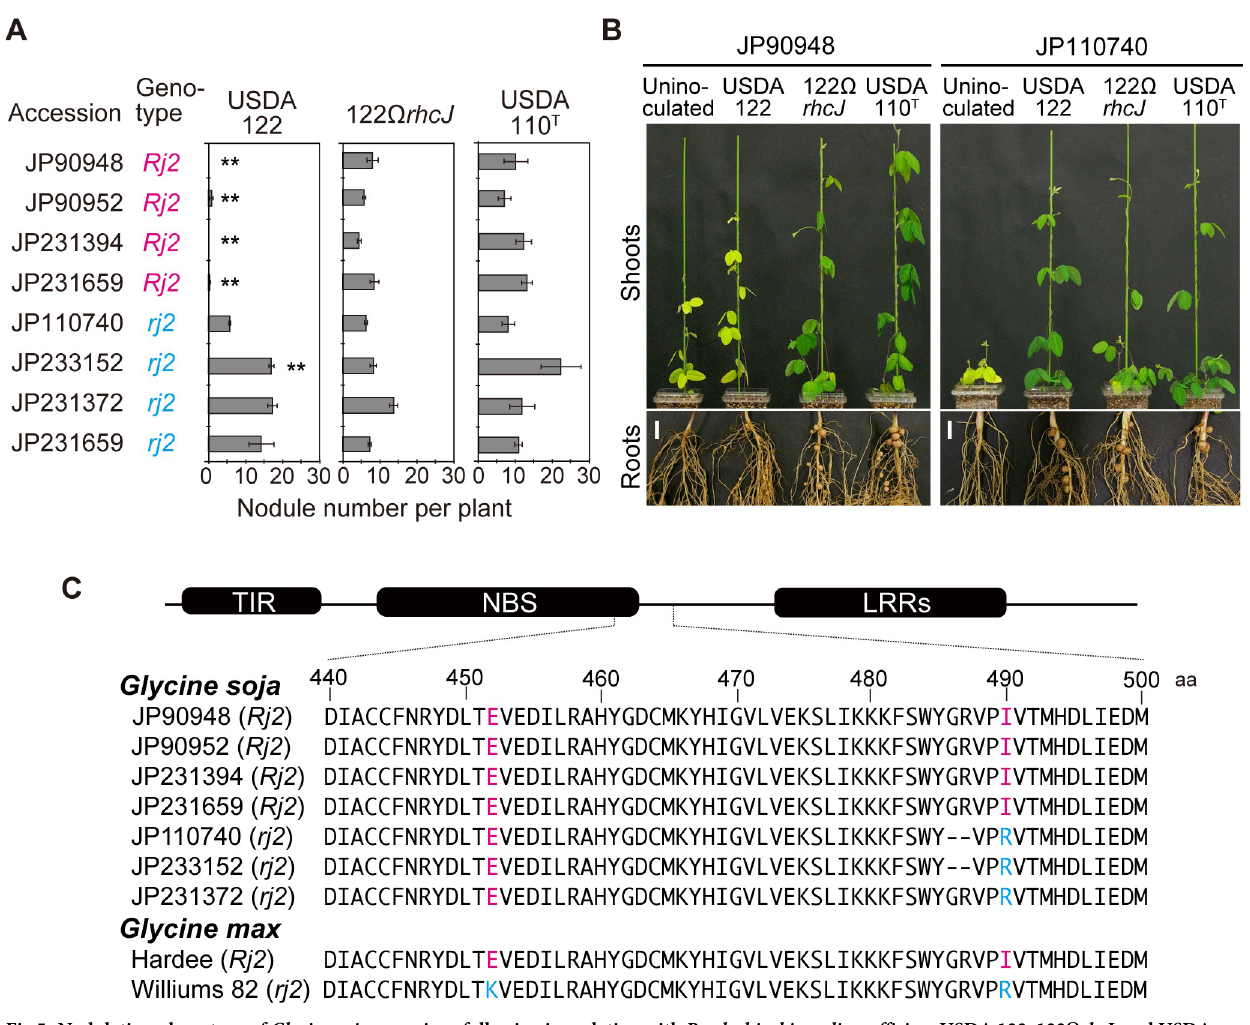
Fig 5. Nodulation phenotype of Glycine soja accessions following inoculation with Bradyrhizobium diazoefficiens USDA 122, 122 O rhcJ , and USDA 110 T . (A) Number of nodules formed on roots of G . soja accessions inoculated with B . diazoefficiens USDA 122, 122 O rhcJ , or USDA 110 T 28 days after inoculation. Error bars show SEM ( n = 4). Significant differences from 122 O rhcJ were detected using Student’s t -test: � P < 0.05, �� P < 0.01. (B) Shoots and roots of accessions JP90948 ( Rj2 ) and JP110740 ( rj2 ) at 28 days after inoculation with B . diazoefficiens strains. Scale bars: 1 cm. (C) Amino acid sequence alignment of the Rj2 and rj2 protein in the G . soja and G . max accessions. The Rj2 - and rj2 -type amino acids at positions 452 and 490 are shown in magenta and cyan letter, respectively.